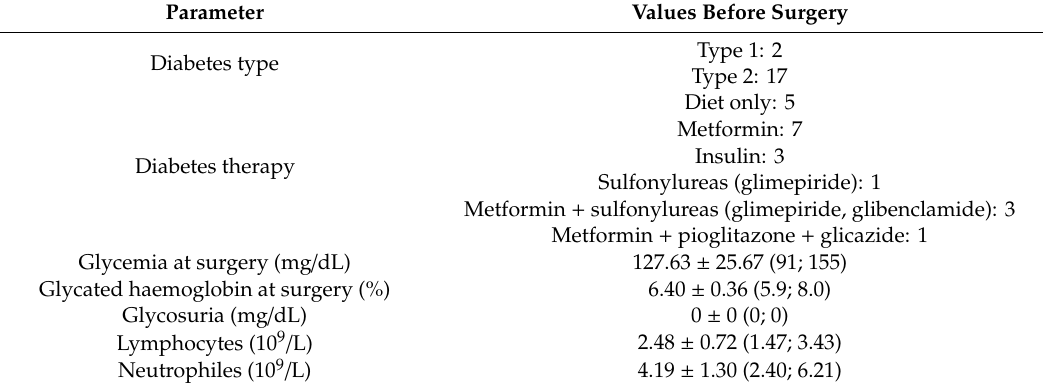
Table 1. Clinical parameters of diabetic patients ( n = 19). Continuous variables are reported as mean ± standard deviation (minimum; maximum). Discrete variables are reported as number of